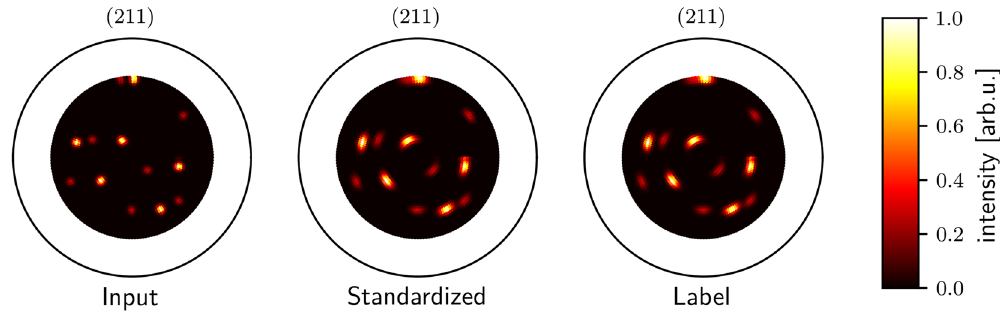
Figure 2. Exemplary result of standardization for a 211 lattice plane pole plot with three visible grains. On the left, we show an input plot with σ φ = 1 and σ ψ = 2 . In the middle, we plot the standardized output with normalized pole widths of σ φ = σ ψ = 2 . There is no noticeable visual difference between the standardized output and the label, except for a slightly brighter background. All pole plots are min-max normalized.